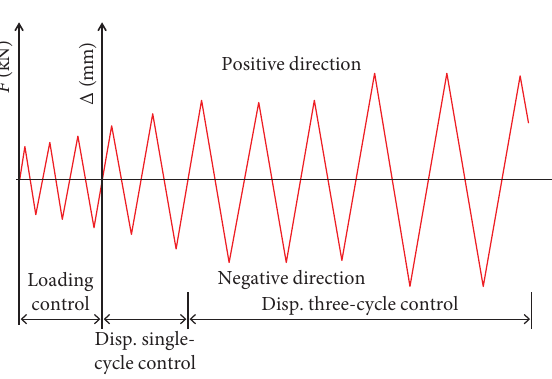
Figure 7: Lateral loading history of experimental